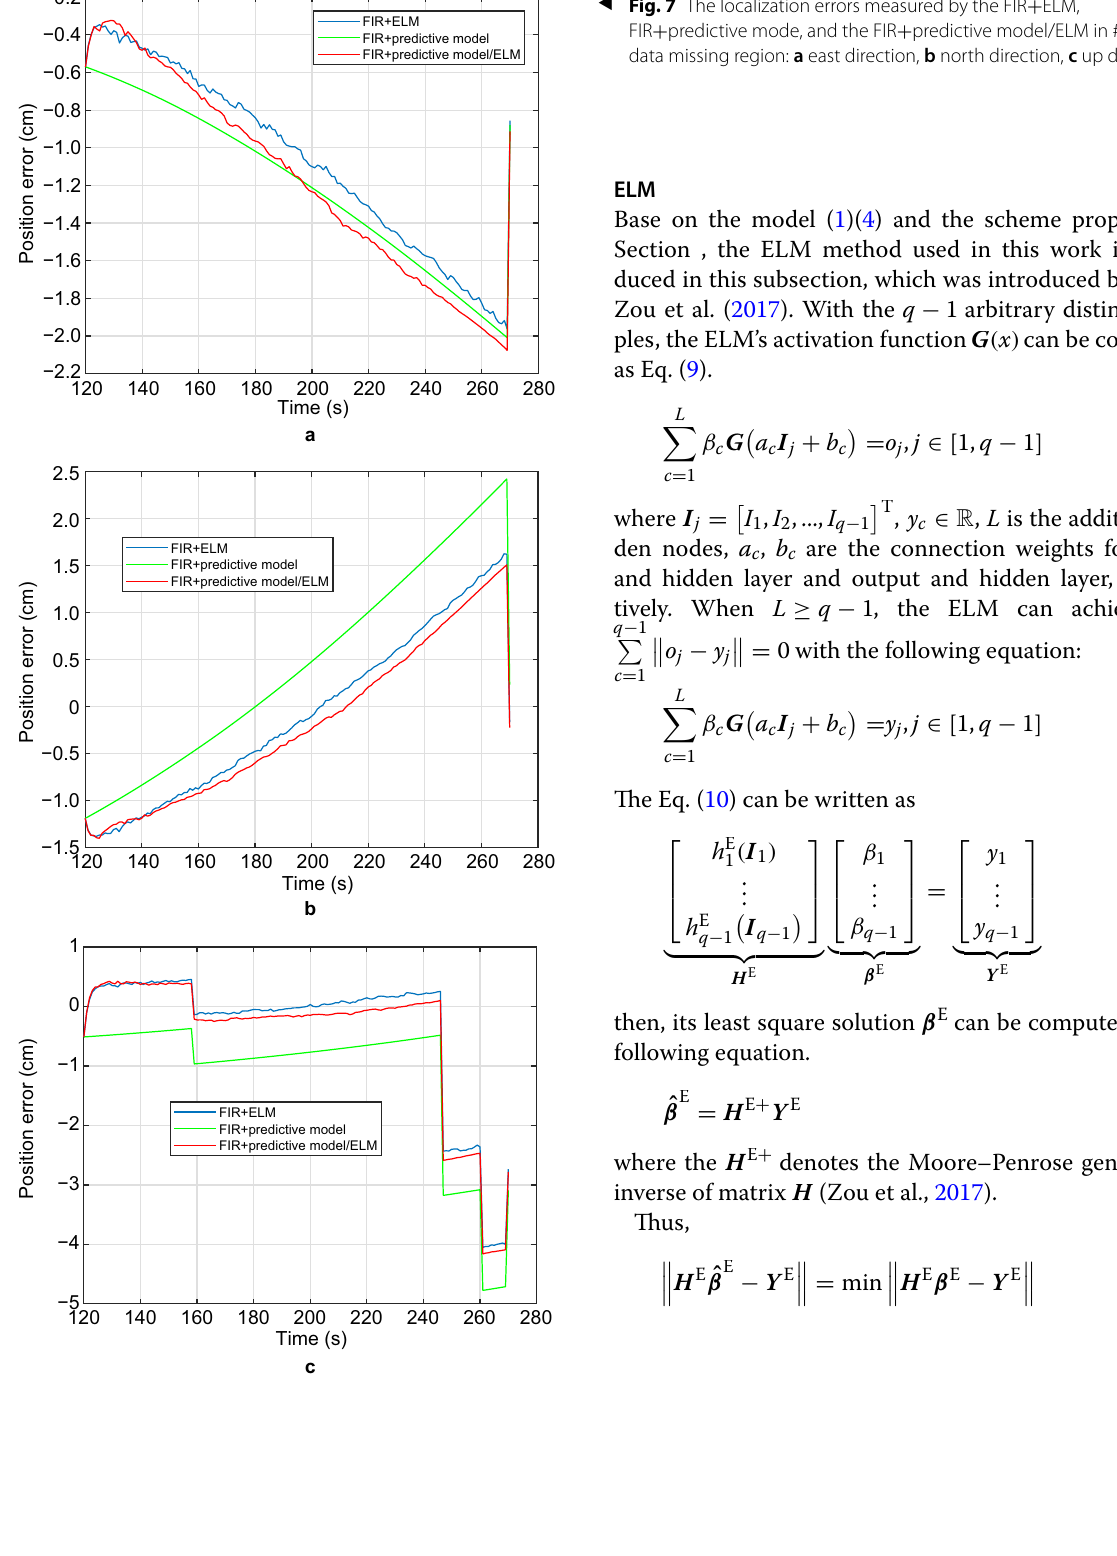
Fig. 7 The localization errors measured by the FIR FIR predictive mode, and the FIR + data missing region: a east direction, b north direction, c up